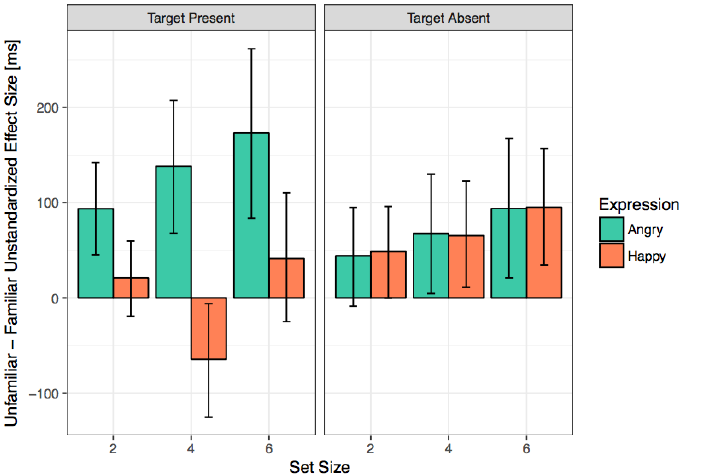
Figure 3. Reaction times (ms) as a function of set size of images. Longer reaction times were observed for unfamiliar faces when the target was an angry expression. Error bars indicate 95% bootstrapped confidence intervals.